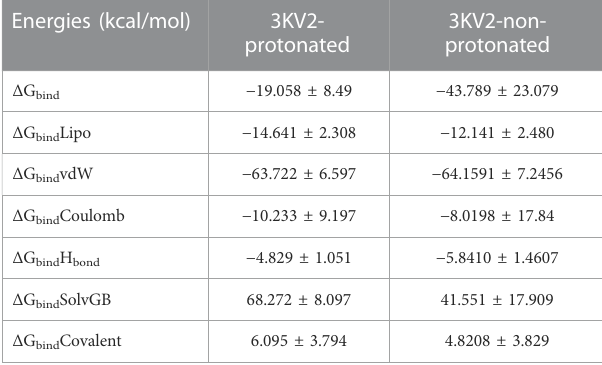
TABLE 4 Binding energy calculation of ZINC000252286875 with 3KV2- Protonated and the 3KV2-non-Protonated interaction energies from MMGBSA